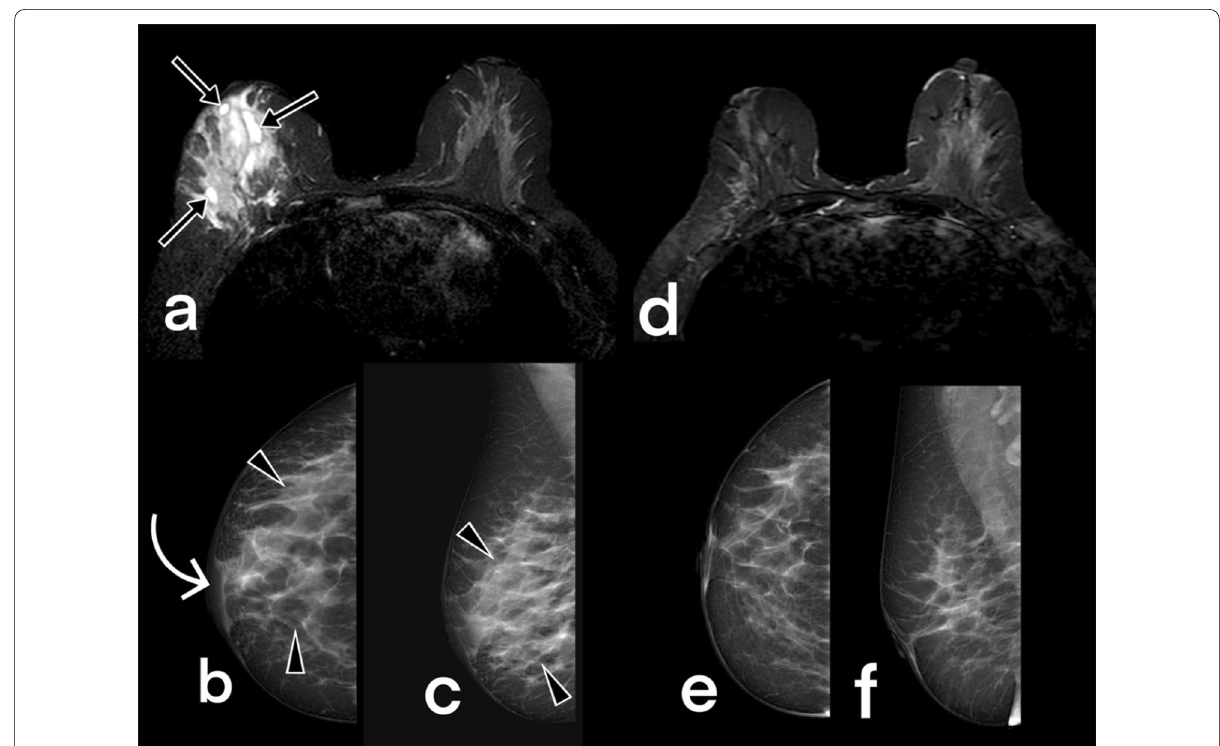
Fig. 16 Images of a 44 years-old female patient obtained before ( a – c ) and 12 months after ( d – f ) antituberculous therapy. T2-weighted fat-suppressed axial image ( a ) demonstrates fluid collections (arrows) and a diffuse signal increase in the right breast. Mammograms ( b , c ) show a diffuse increase (BIRADS 4) in parenchymal opacity (arrowheads) and thickening of the skin (curved arrow). After the treatment, complete regression (BIRADS 1) of the findings is observed ( d – f